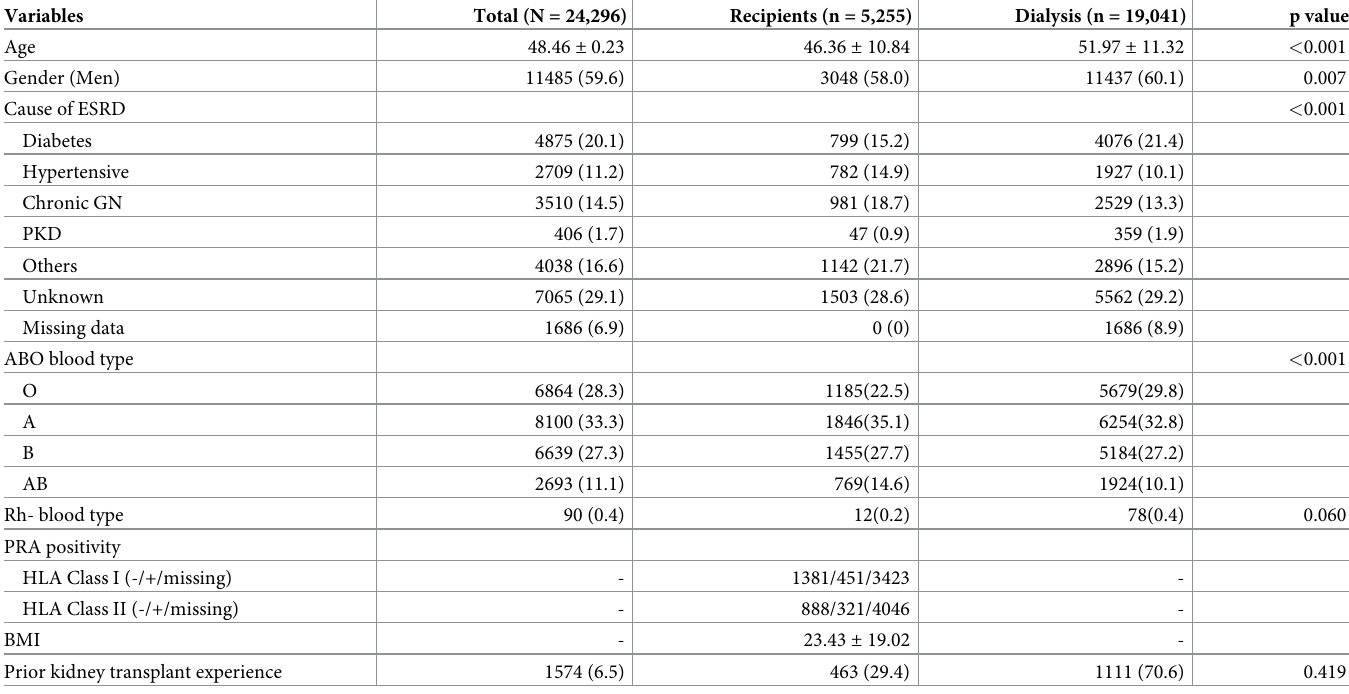
Table 1. Baseline characteristics of deceased donor kidney transplant recipients and characteristics of those who remained on